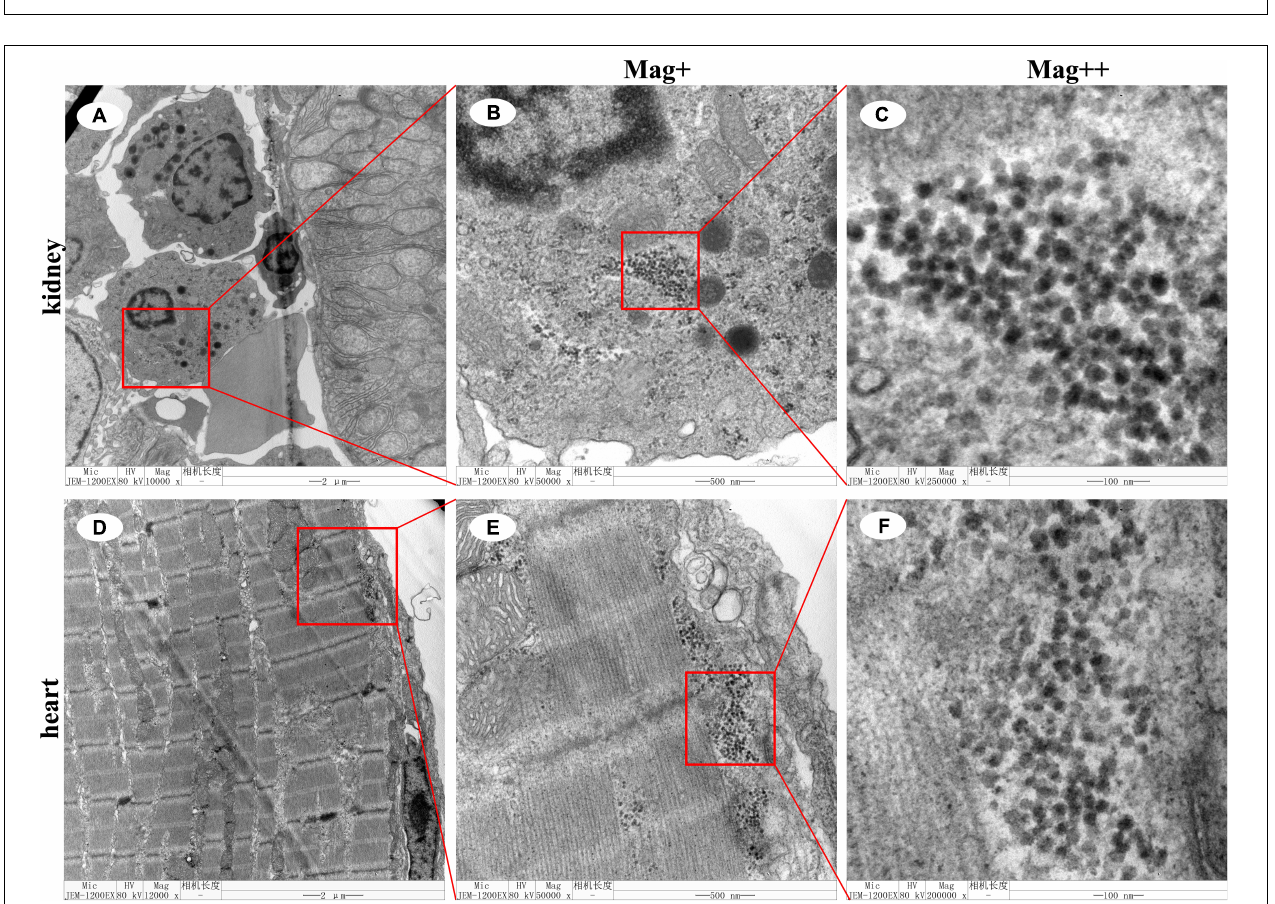
FIGURE 3 | Transmission electron microscopic micrographs of ultrathin section of kidney and heart of the Larimichthys crocea . (A) The blood cells of the kidney of the L. crocea . (B) Magnified micrograph of the blood cells in the red frame in (A) . Note mass CMNV-like particles distributed in the blood cells. (C) Magnified micrograph of the CMNV-like particles in the red frame in (B) . (D) The cardiac muscle of the heart of the L. crocea . (E) Magnified micrograph of the cardiac muscle in the red frame in (D) . Note mass CMNV-like particles distributed in the cardiac muscle. (F) Magnified micrograph of the CMNV-like particles in the red frame in (E) . Scale bars, (A,D) , 2 µ m, (B,E) , 500 nm, and (C,F) , 100